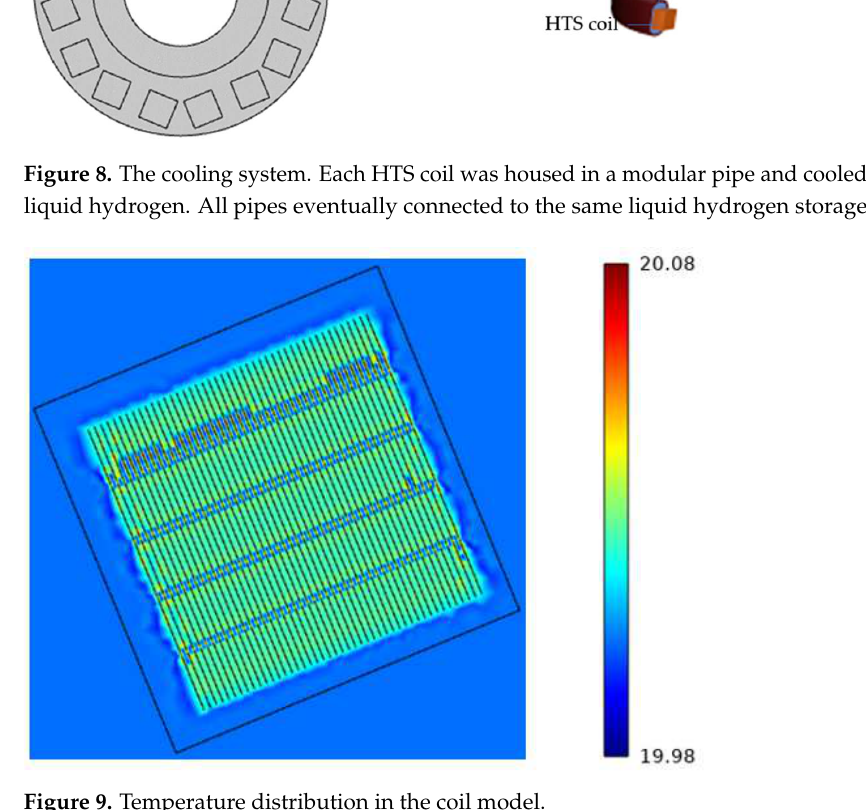
Figure 8. The cooling system. Each HTS coil was housed in a modular pipe and cooled by circulating liquid hydrogen. All pipes eventually connected to the same liquid hydrogen storage tank.